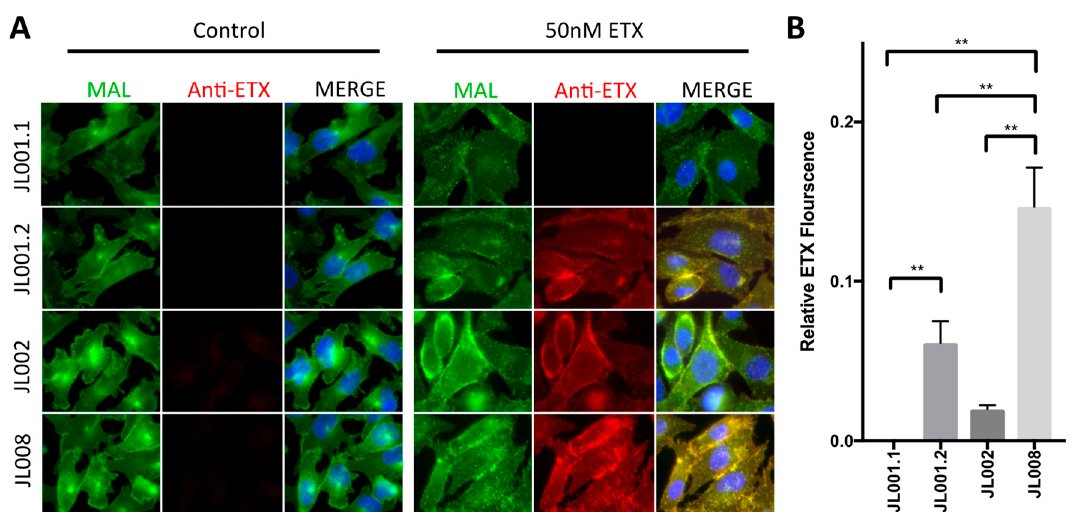
Figure 5. Evaluation of ETX detection via immunocytochemistry (ICC). ( A ) rMAL-CHO cells expressing MAL-GFP fusion protein (green) were treated with or without 50 nM ETX for 30 min. Cells were washed, fixed, blocked, and probed with anti-ETX antibodies. Antibody binding was detected using at Cy-3 conjugated anti-rabbit antibody (red) and visualized by fluorescent microscopy. ETX was detected using JL011.2, J002, and JL008 and colocalized with rMAL-GFP. ETX was not detected with JL001.1 or JL004, JL005, and JL006 (images not shown). ( B ) Relative ETX fluorescence detected on 50 nM ETX-treated rMAL-CHO cells with individual antibodies. JL001.1 was used as a negative control. Results are mean ± SD. ** p < 0.01 determined by one-way ANOVA with post-hoc Tukey HSD.